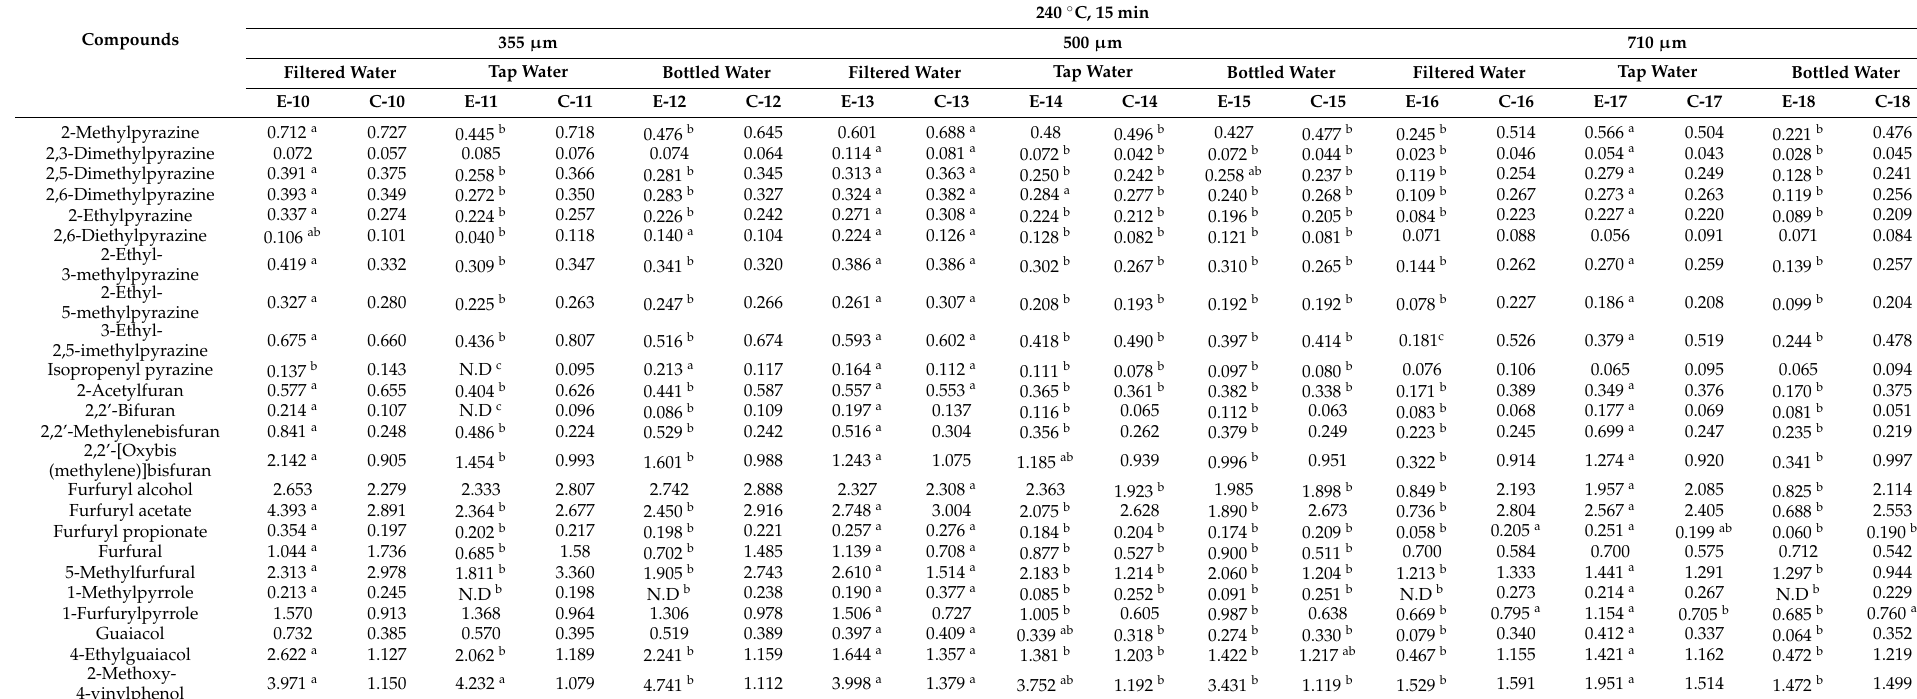
Table 3. Volatile compounds in coffee roasted at 240 ◦ C for 15 min (model E-10 to E-18 for expresso, C-10 to C-18 for cold brew). The sample number was also assigned to the particle size of